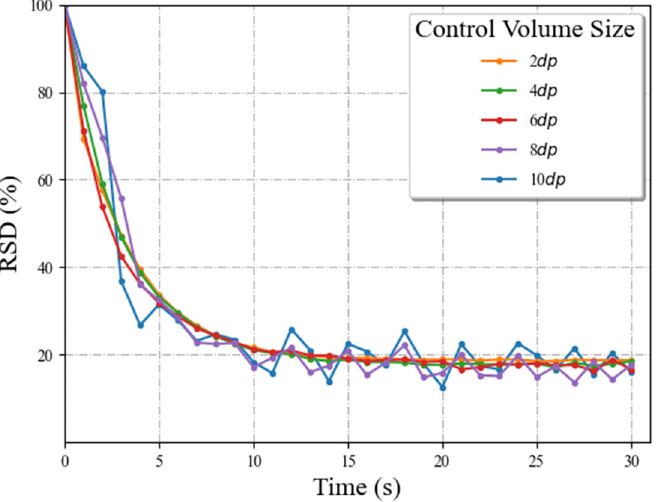
Figure 6. Sensitivity analysis for the effects of control volume size on the RSD values.